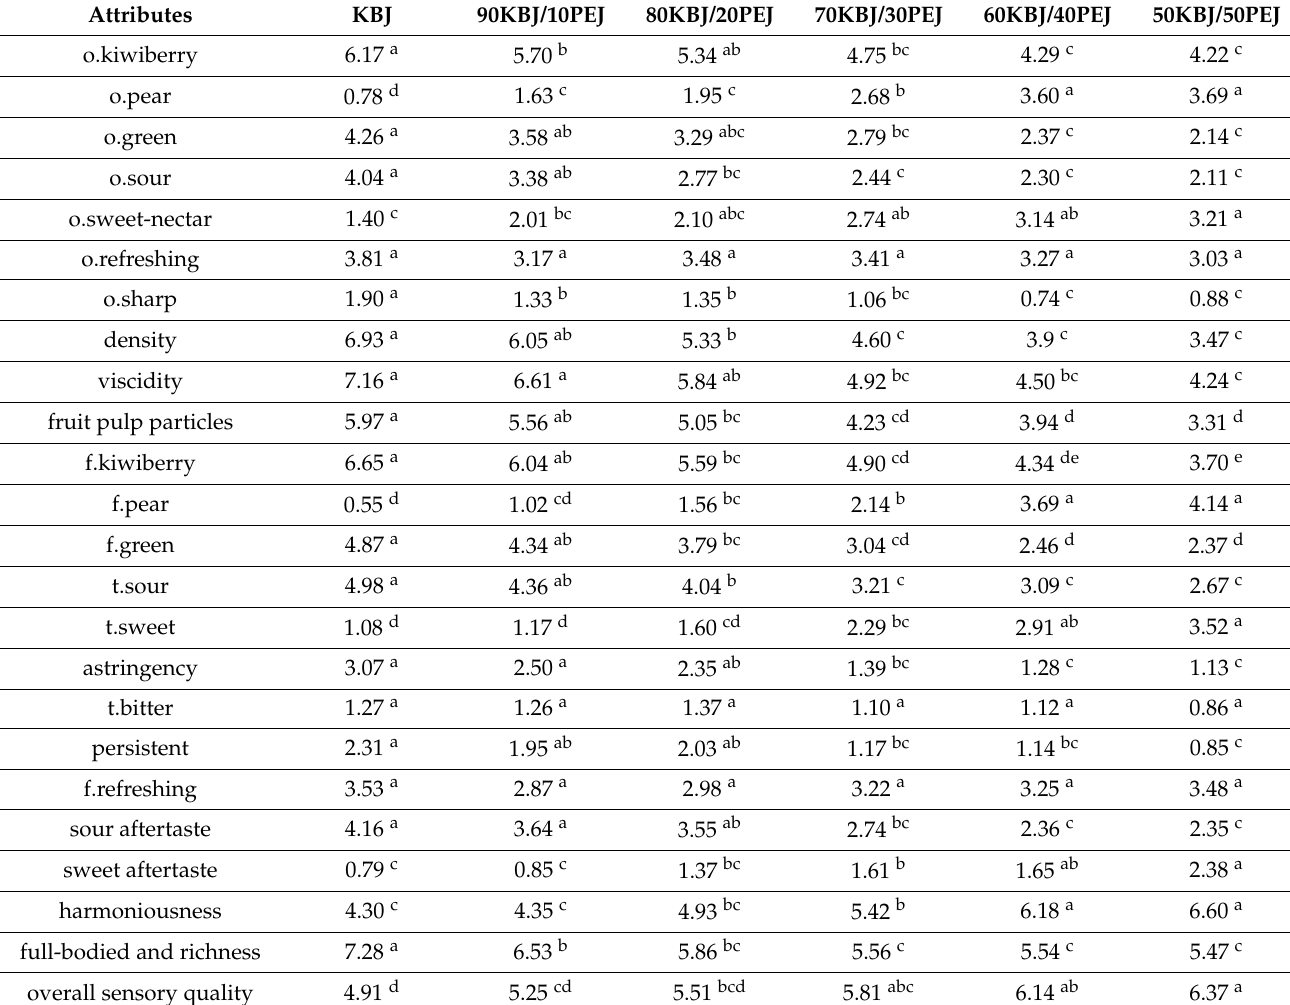
Table 5. Sensory profiling of the kiwiberry juice and kiwiberry/pear juice